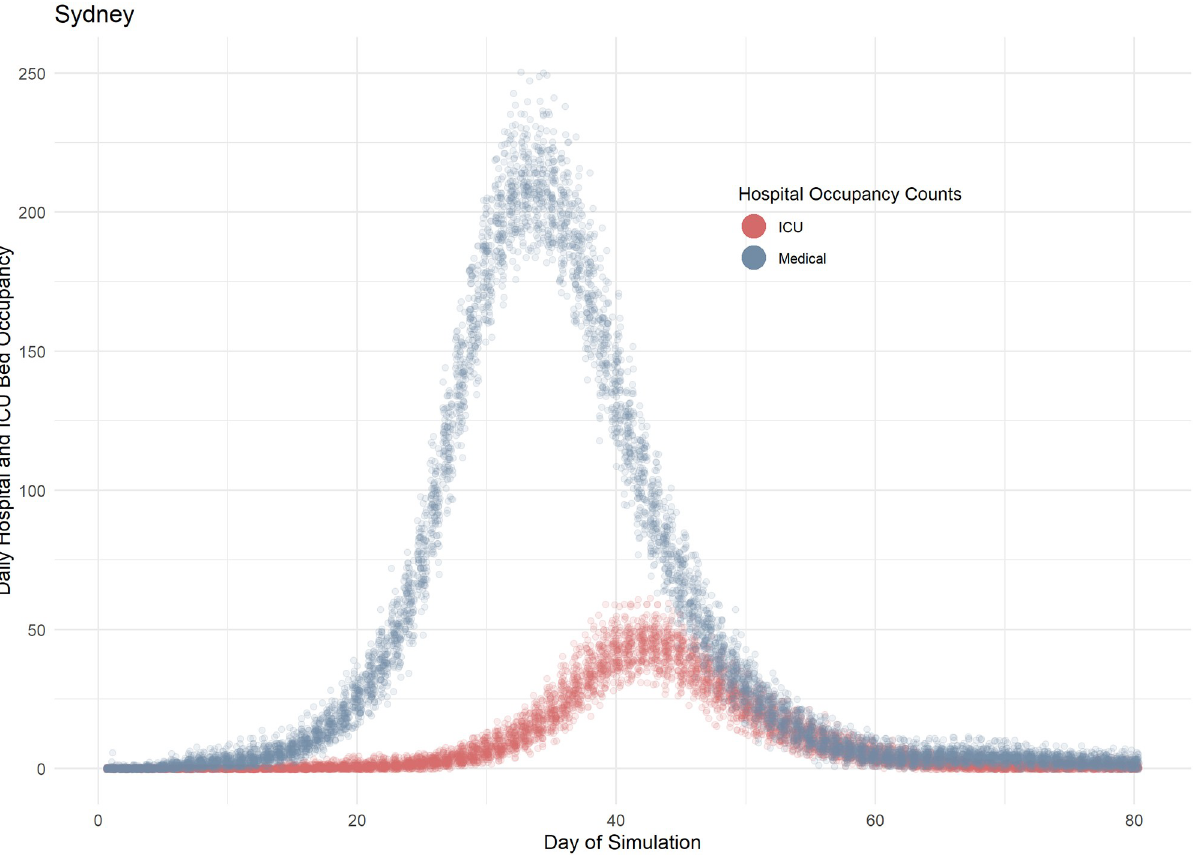
Fig 3. Simulated hospital occupancy in Sydney. The simulated prevalence of occupied medical and ICU beds is modelled as a function of the likelihood of requiring admission to hospital and subsequently requiring ICU care. The delayed peak in the ICU curve is demonstrative of the disease course, i.e. ICU requirements lag behind medical bed requirements. Each simulation is composed of 100 runs (each data point represents one day of simulation) which generates the spread of results seen here and the stochasticity that is inherent to ABMs.